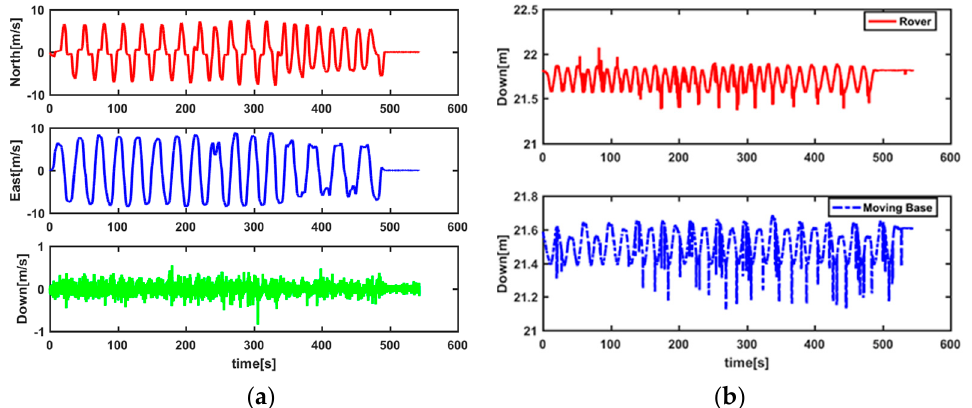
Figure 9. Velocities (NED) of vehicles in test 1. ( a ) Rover; ( b ) moving base.